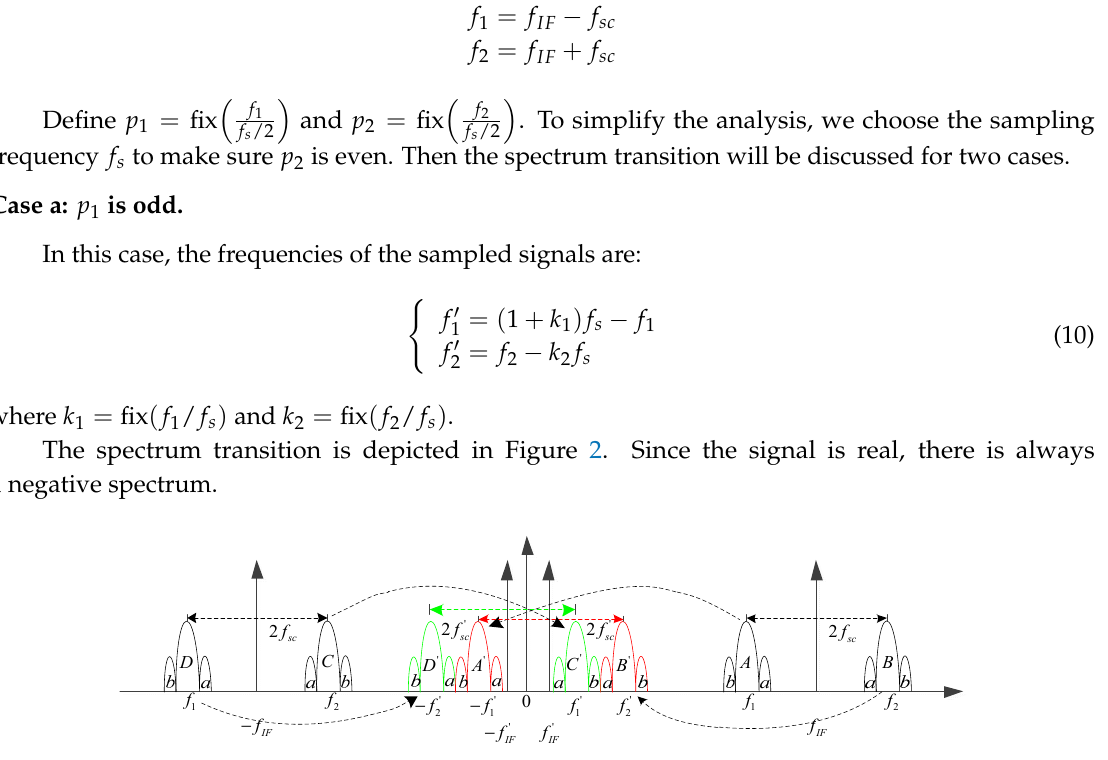
Figure 2. Spectrum transition where p 1 is odd.